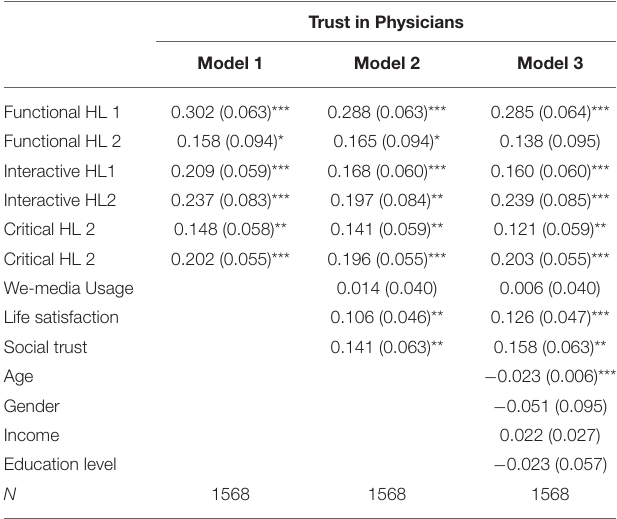
TABLE 4 | Ordinal logistic regression analysis of health literacy and trust in